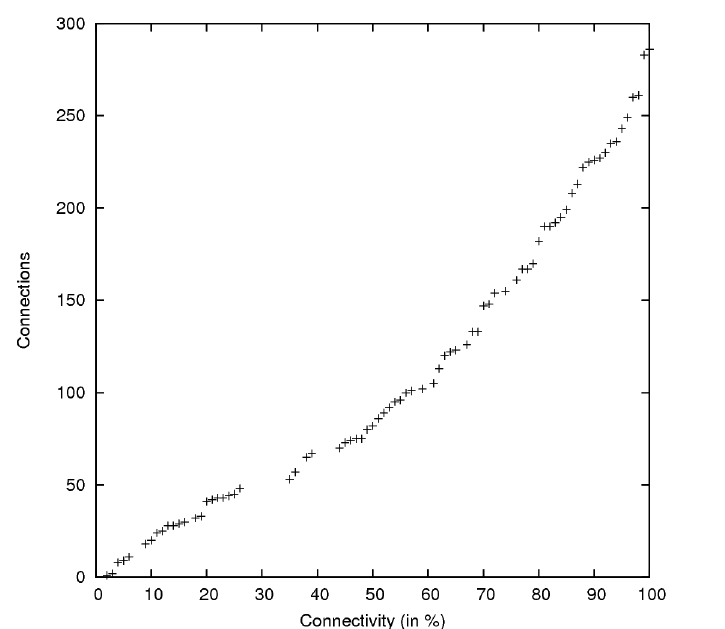
Figure 3. Plot of connections by connectivity of one simulation run.